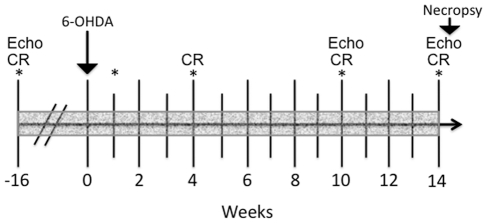
Experimental timeline.All procedures were performed in 5 adult rhesus monkeys following a within-subject experimental design. MHED PET scans, plasma catecholamines, troponin I and ECGs (*) were performed at baseline and 1, 4, 10 and 14 weeks after 6-OHDA. Echocardiograms (Echo) were obtained at baseline and 10 and 14 weeks after 6-OHDA. Clinical rating (CR) was performed at baseline and 4, 10 and 14 weeks following toxin administration. Food consumption and feces were monitored daily and body weight was measured weekly throughout the course of the study (shading). Animals were euthanized 14 weeks following 6-OHDA administration.